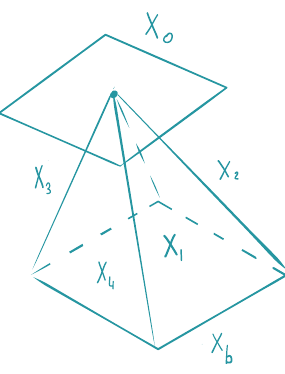
Figure 6 . A square pyramid is not simple because the four facets X 1 , X 2 , X 3 and X 4 meet at a common vertex. The standard triangulation of the dual involves the external facet X 0 in addition to the plane at